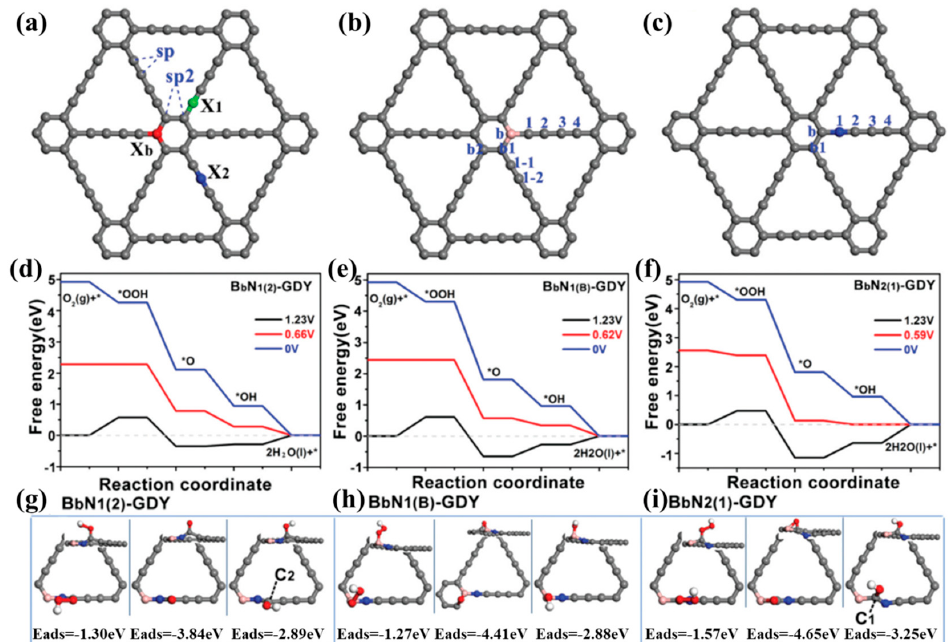
Figure 9. Geometric structures, free energy and intermediate adsorption diagrams of heteroatom-doped GDY. Geometric structures of ( a ) single-heteroatom-doped GDYs, ( b ) B b N y -doped GDY and ( c ) B z N 1 -doped GDY monolayers. Free energy diagrams for ( d ) B b N 1(2) -, ( e ) B b N 1(B) - and ( f ) B b N 2(1) -doped GDY sheets. The optimized adsorption structures of *OOH, *O and *OH and the corresponding adsorption energy on ( g ) B b N 1(2) -, ( h ) B b N 1(B) - and ( i ) B b N 2(1) -doped GDY monolayers. Gray, pink, blue, red and white balls represent C, B, N, O and H atoms, respectively (reproduced with permission from [105] . Copyright The Royal Society of Chemistry, 2019).